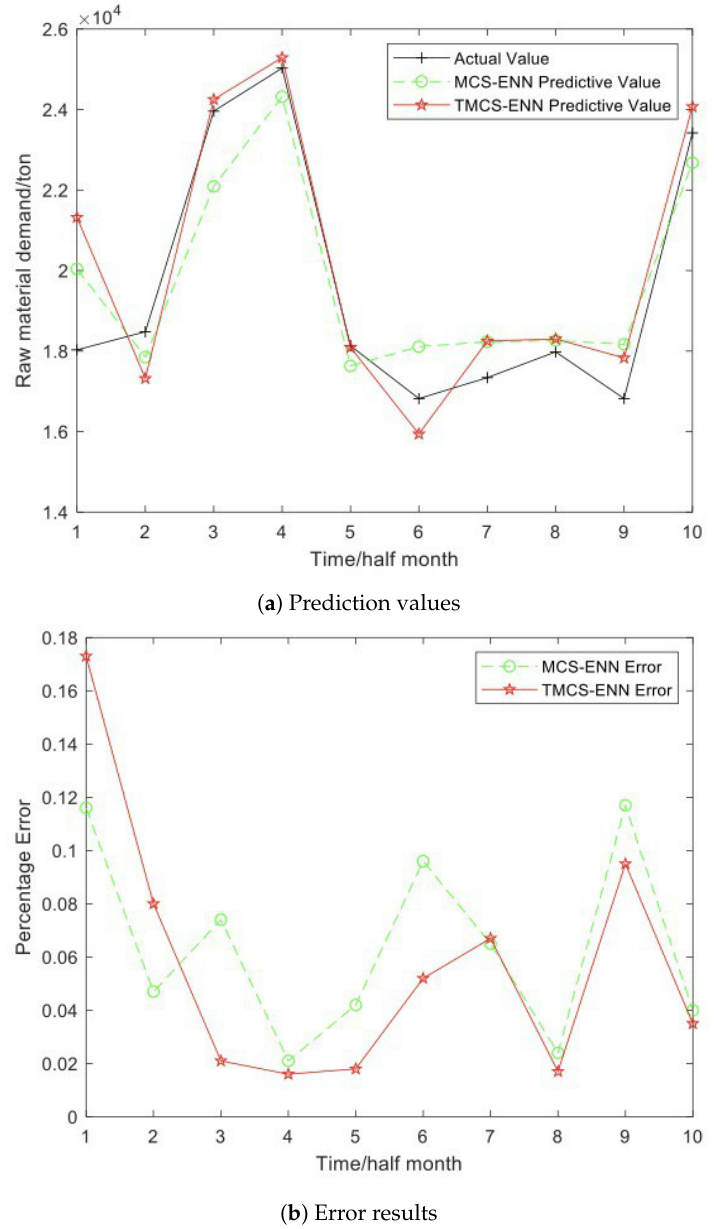
Figure 12. MCS-Elman and TMCS-Elman prediction results (half month).